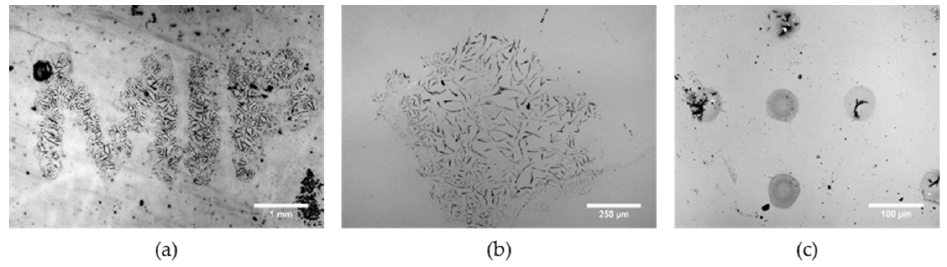
Figure 4. ( a , b ) Brightfield images of the MIP pattern and polymerized droplet of a MIP with the solvent butyronitrile. Enrofloxacin precipitates as little needles; ( c ) polymerized droplets using 1-methylnaphthalene as a solvent.